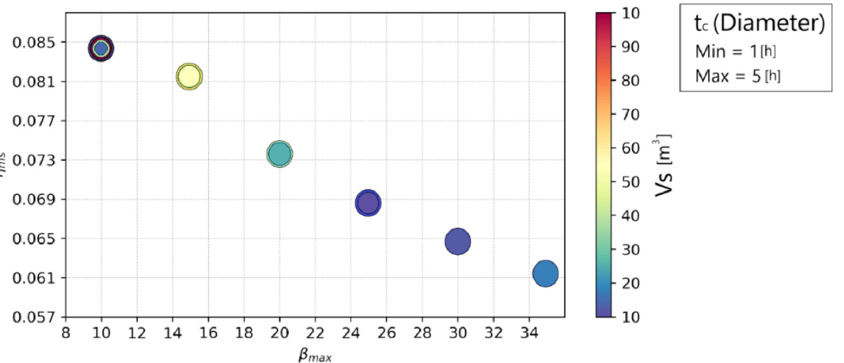
variables ( 𝑃 (cid:3032),(cid:3040)(cid:3028)(cid:3051) , 𝑡 (cid:3031) , 𝜂 (cid:3040)(cid:3046) ).